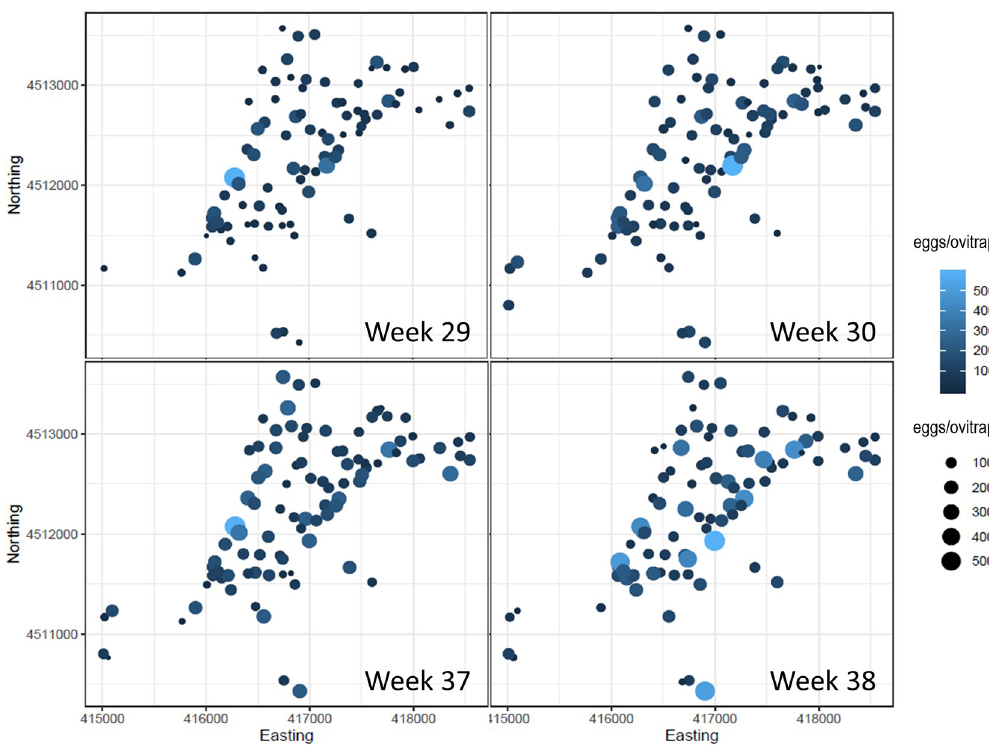
Fig 3. Number of Ae . albopictus eggs/ovitrap/week on Procida Island in July and September 2016. Spatial coordinates Northing and Easting are expressed in meters using the coordinate reference system with EPSG code 32633 (https://epsg.io/ 32633). Circles represent the positions of the 101 ovitraps utilized for the spatial analysis. Circle size and colour scales are proportional to the magnitude of collected eggs/ovitrap. The double scale for the same parameter enables the resolution of the overlapping circles in the